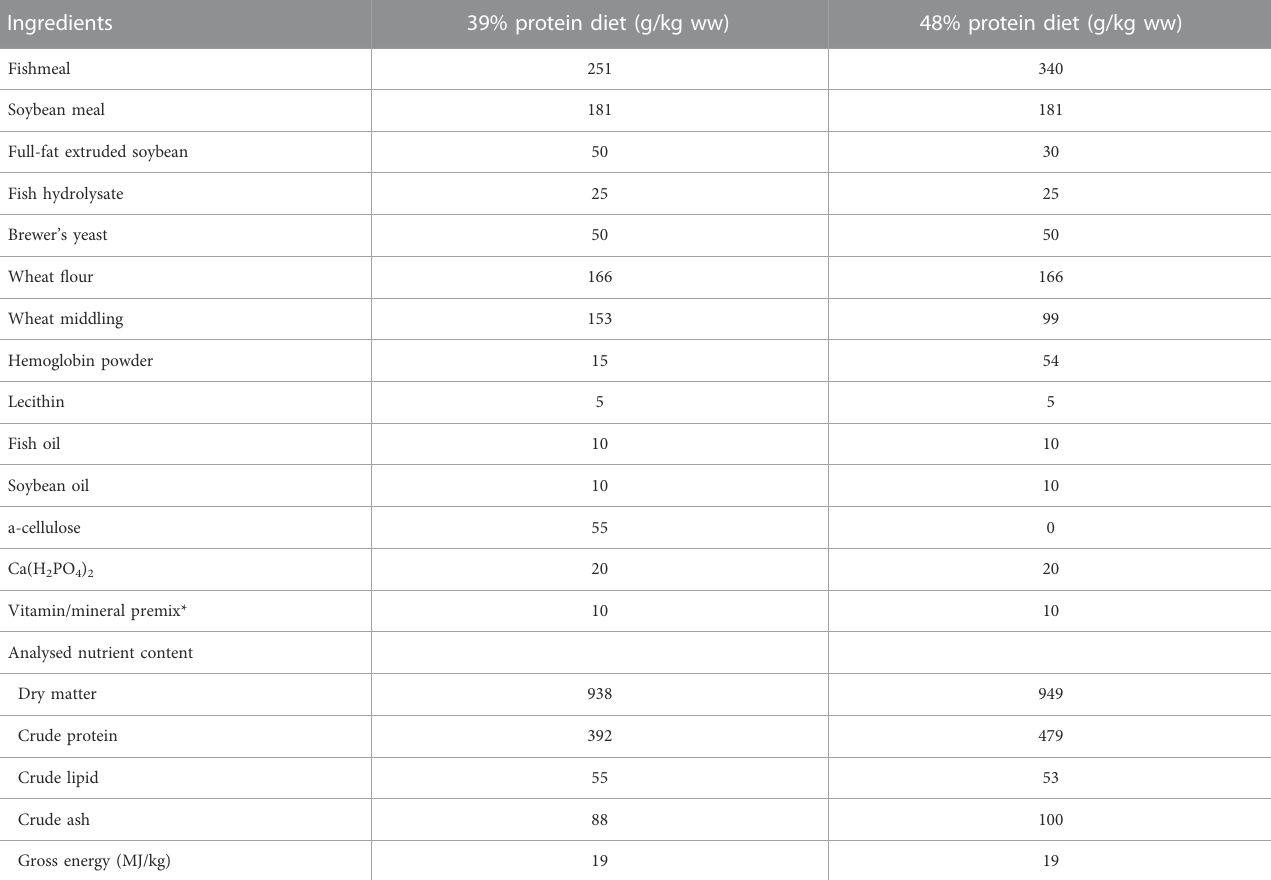
TABLE 1 Composition of experimental diets used in the feeding experiment. Ingredients Fishmeal